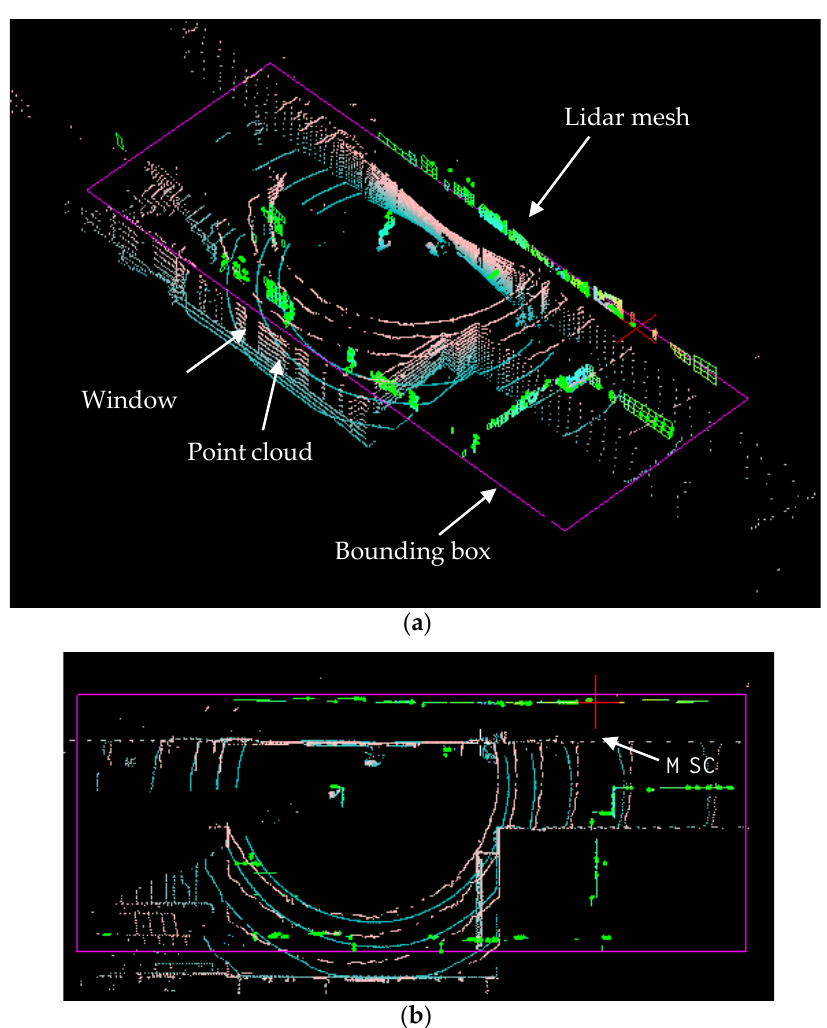
Figure 5. Initial axis finding with minimum bounding box: ( a ) perspective view and ( b ) top view.